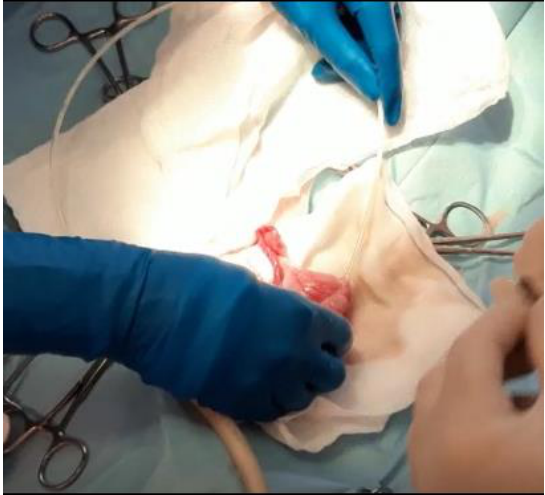
Figure 4. A sterile catheter is inserted into the uterus through a 2 mm incision in the apex of each horn.